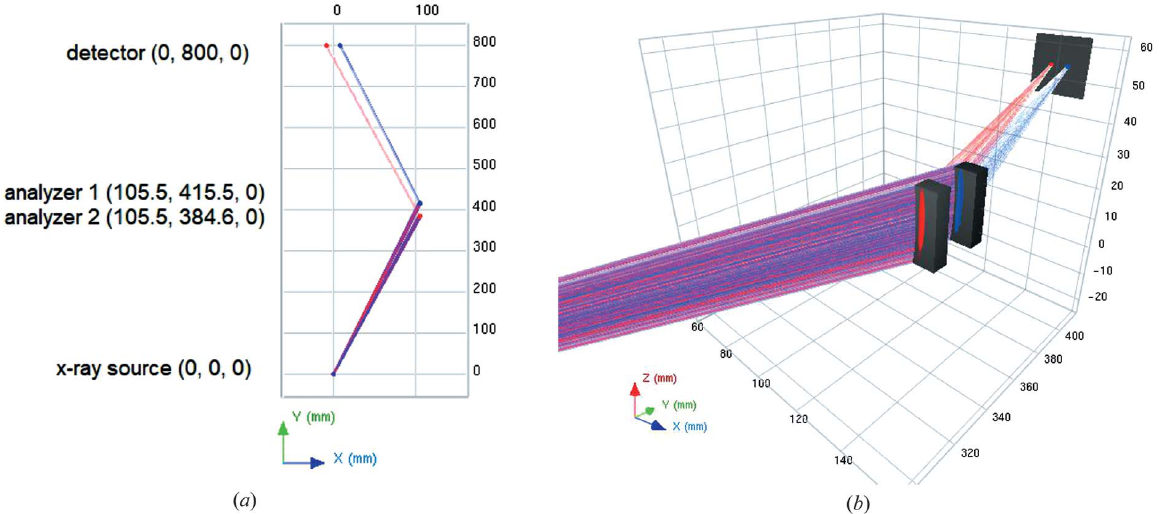
Figure 1 (Left) Layout of the XRayTracer -simulated spectrometer. The X-ray source is located at the origin; the two analyzer crystals, approximating the conical analyzer, are represented with the blue and red reflection points at x = 105.5 mm, while the detector plane is parallel to the x -axis and is at y = 800 mm (the center positions of the components as well as the scales are given in millimetres). (Right) 3D visualization of the setup used for the ray-tracing simulations. Red and blue tracks represent Ni and Cu K (cid:2) radiation, respectively. The plasma source is not shown here; the detector surface is represented by the dark gray square at the far side of the picture, perpendicular to the line connecting the source and the detector. The conical analyzer is simulated by two narrow cylindrical analyzers with bending radius equal to that of the conical analyzer at the same position (109.7 mm and 103.4 mm for Ni and Cu,